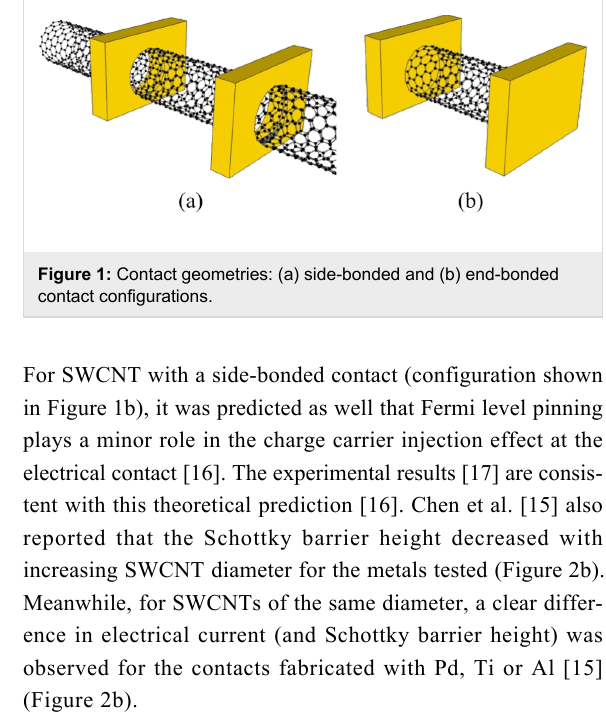
For SWCNT with a side-bonded contact (configuration